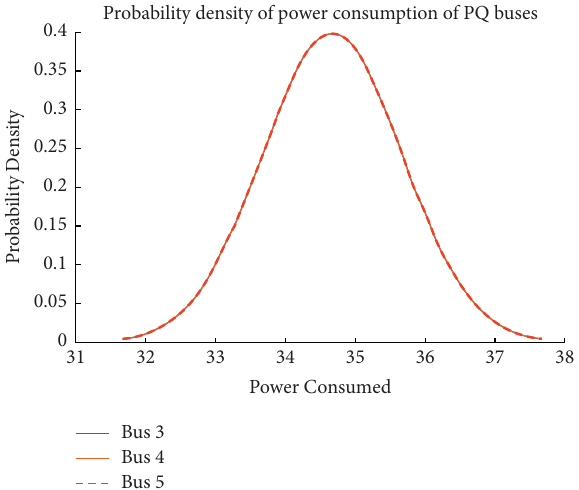
Figure 13: Power density distribution at buses 3–5.